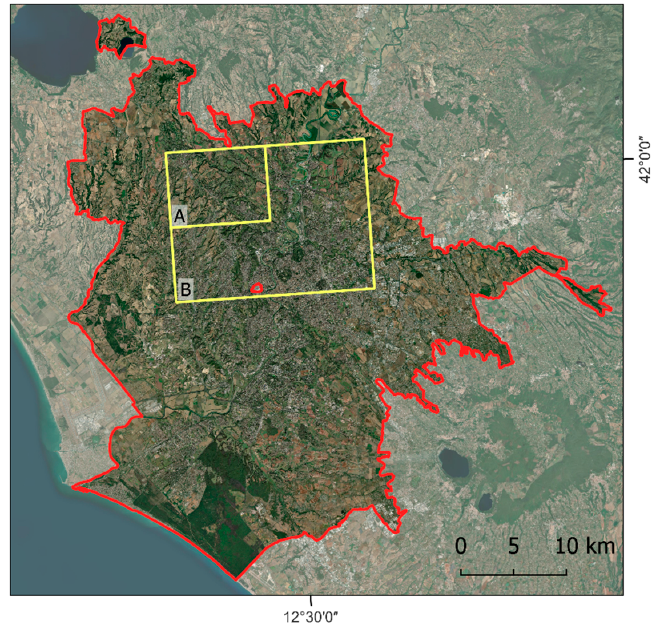
Figure 2. Test area in the Municipality of Rome used for the application and comparison of different algorithms against different input data. The portion A is the “validation area” while B is the “training area”.